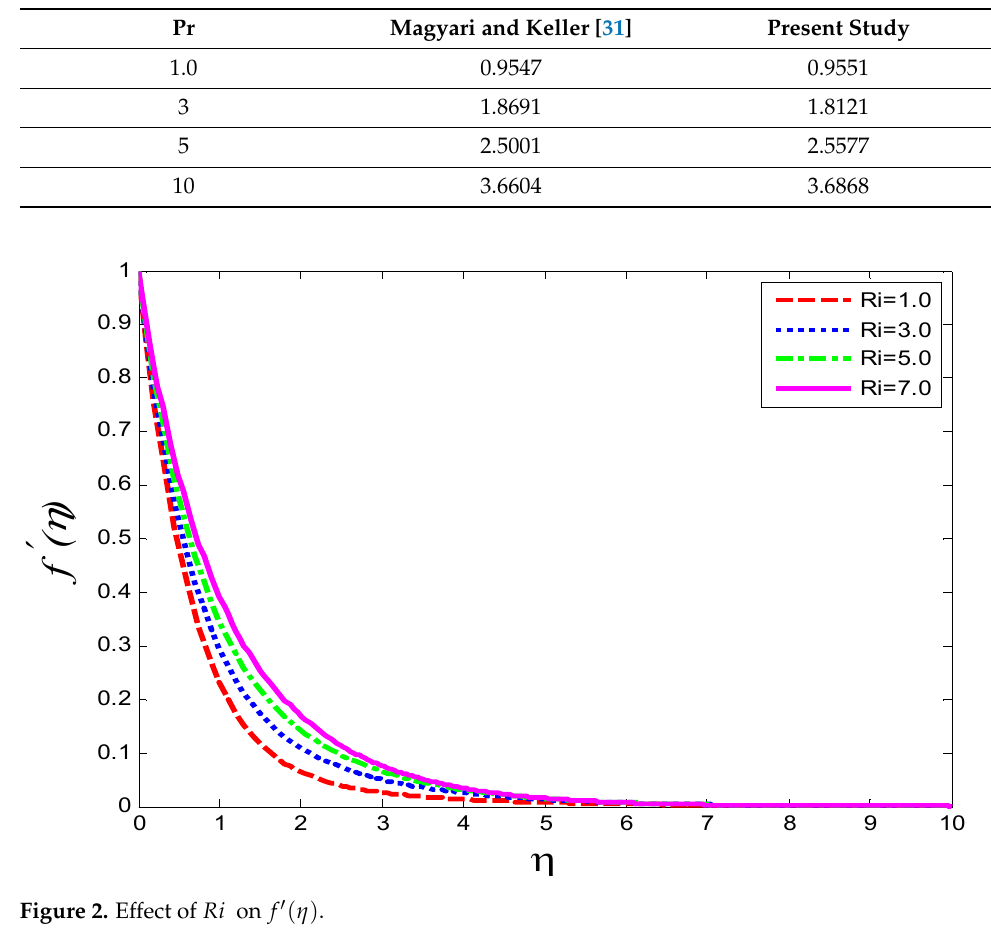
Figure 3. Effect of 𝑁 on 𝜃(cid:4666)𝜂(cid:4667) .